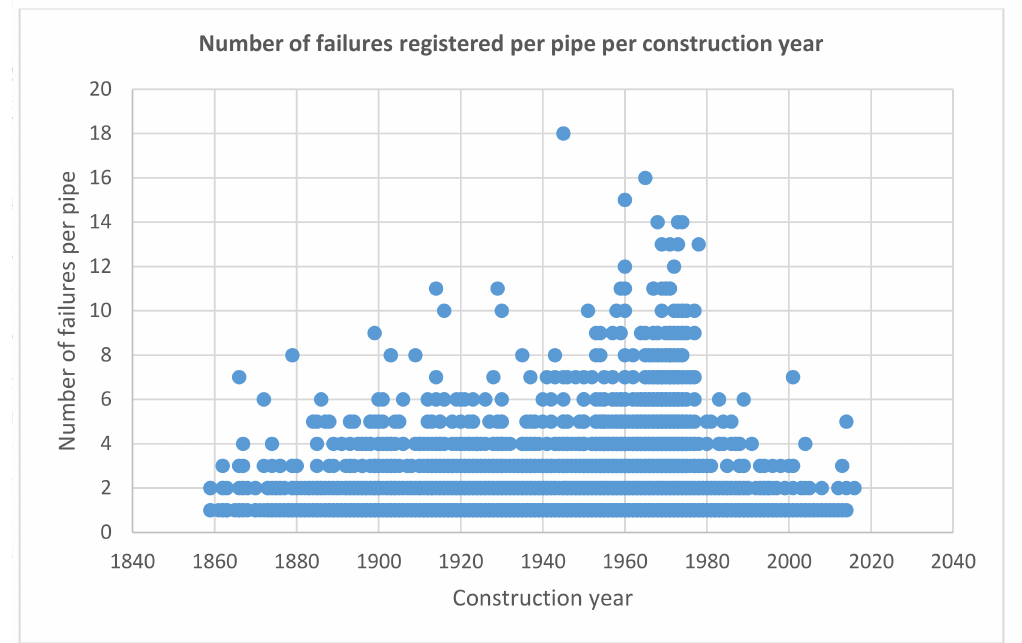
Figure 4. Number of failures correlated against construction year of